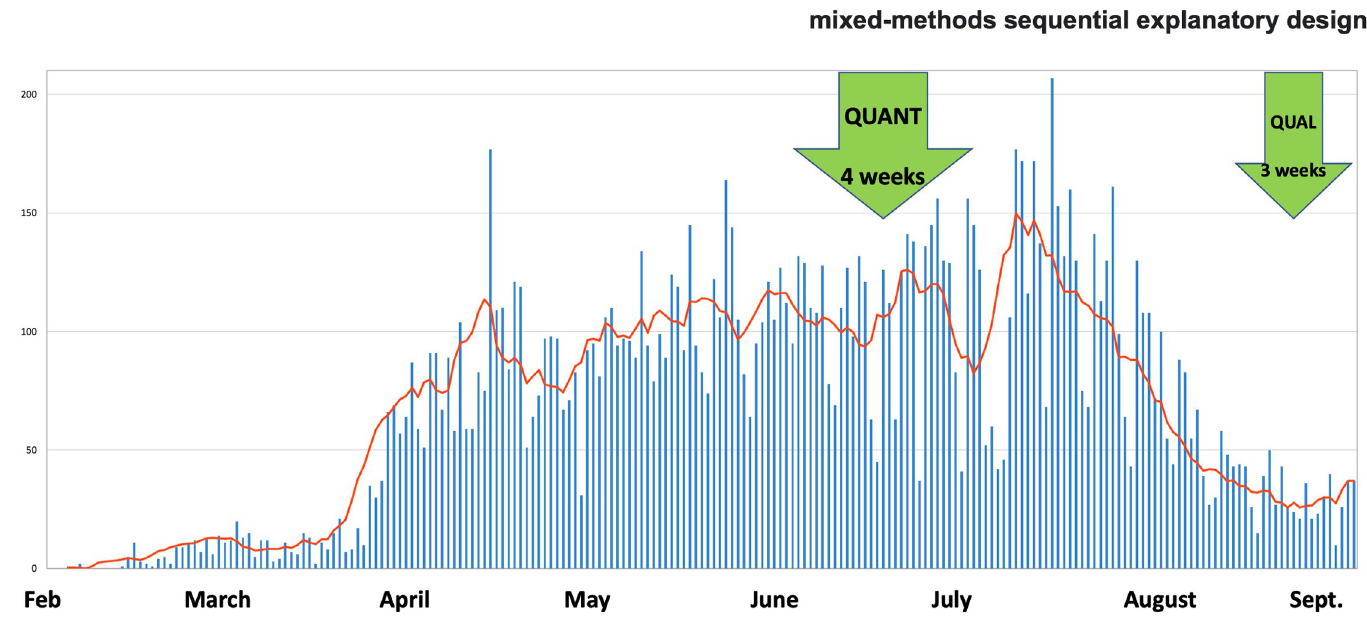
Fig 1. Evolution of the number of cases in Senegal and date of completion of the two